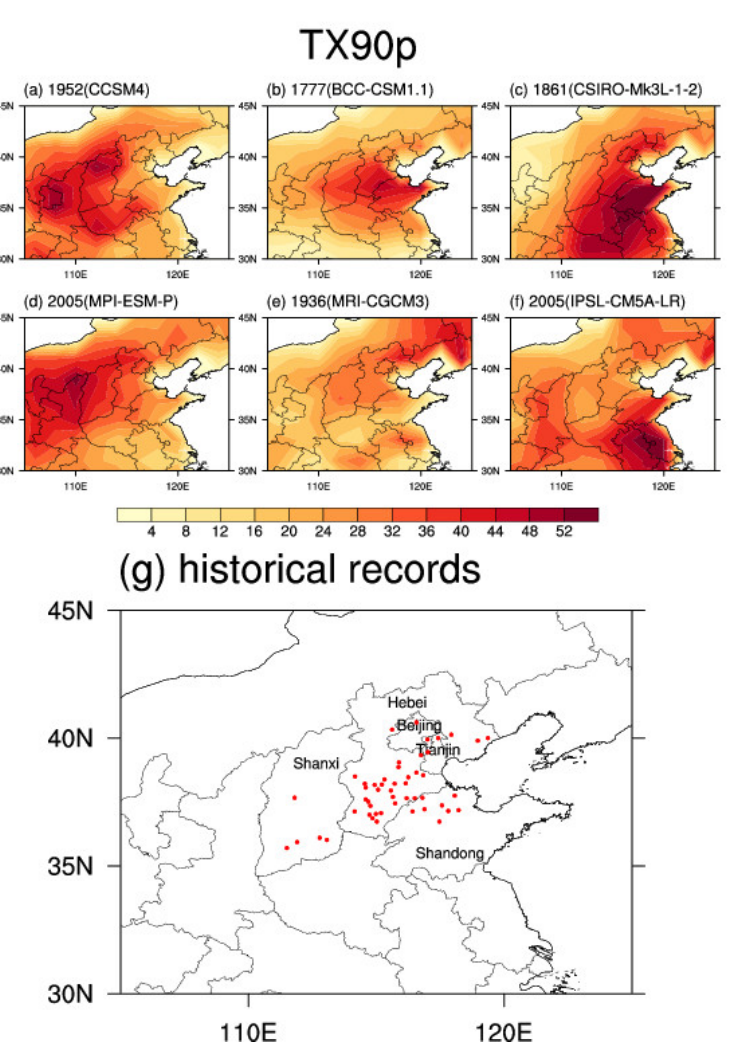
Figure 7. Spatial distributions of the maximum TX90p simulated with individual models and the recorded extreme events in 1743 CE. The red dots in ( g ) indicate the location of the records. Despite the notable model-data mismatches, the simulated shifts in the periods of warm extremes were authentic. In YRV, the shift in periods happened around 1850 CE, which is clearly associated with global warming after the industrial revolution [90]. In NC,